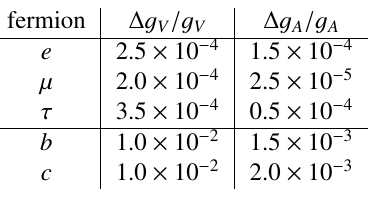
Table 1. The relative uncertainties on fermion vector and axial neutral couplings to Z, as expected at the FCC-ee